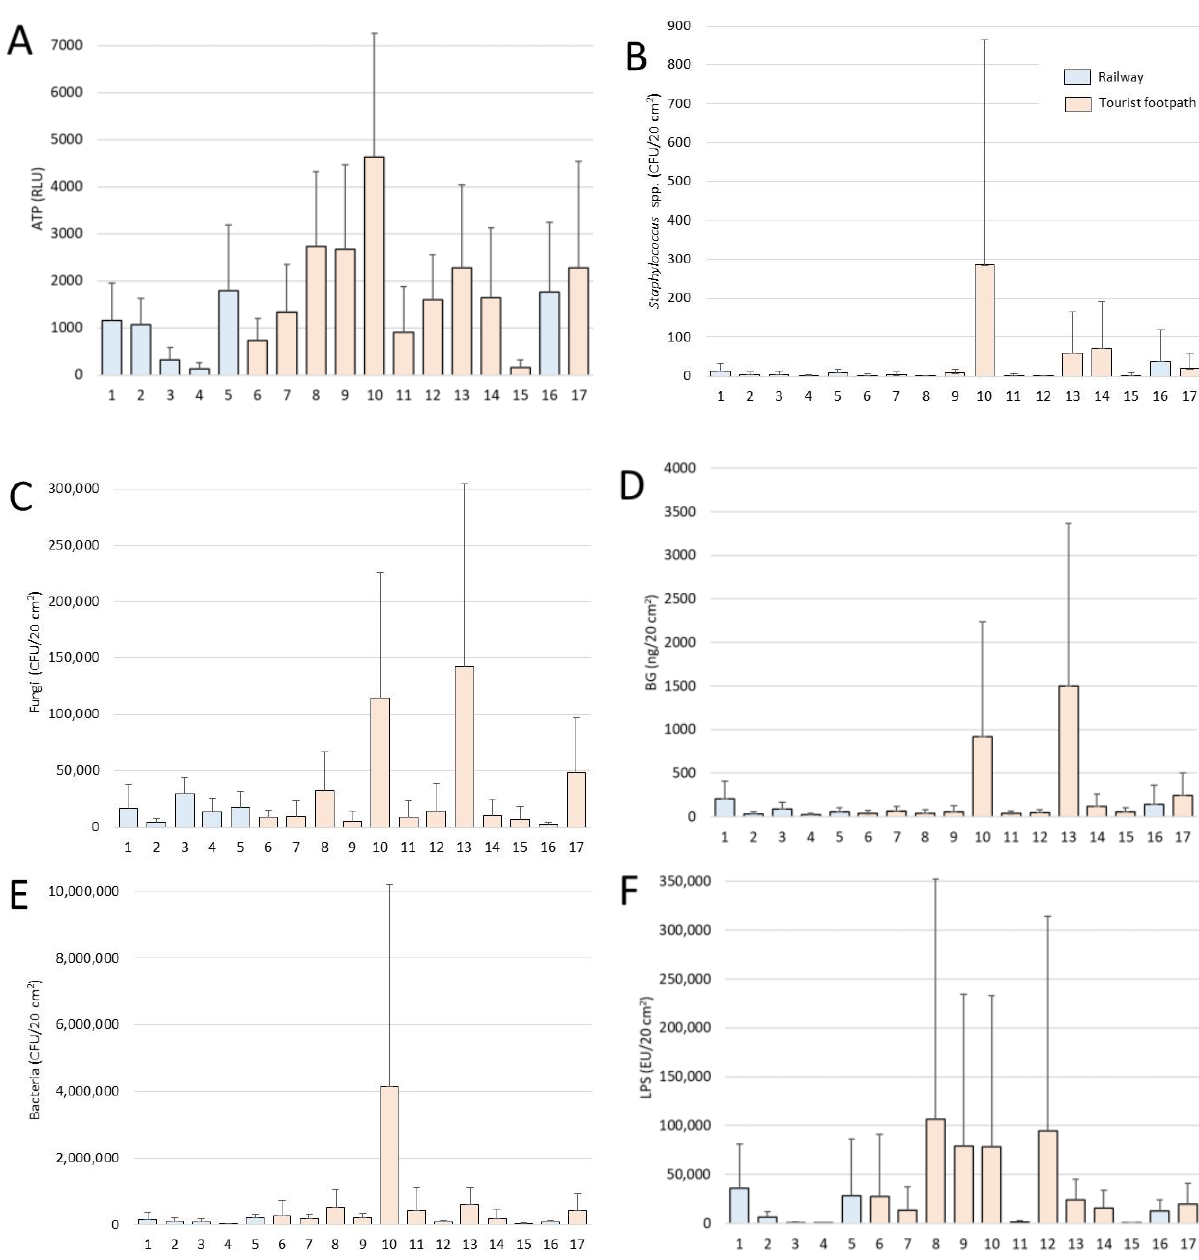
Figure 4. Biomass parameters from experimental periods 2018–2019 and 2019–2020 per individual sites (1–17): ( A )—ATP as total microbial biomass, ( B )— Staphylococcus spp., ( C )—fungi, ( D )—BG, ( E )—bacteria, ( F )—LPS. Results are presented as mean ± SD.